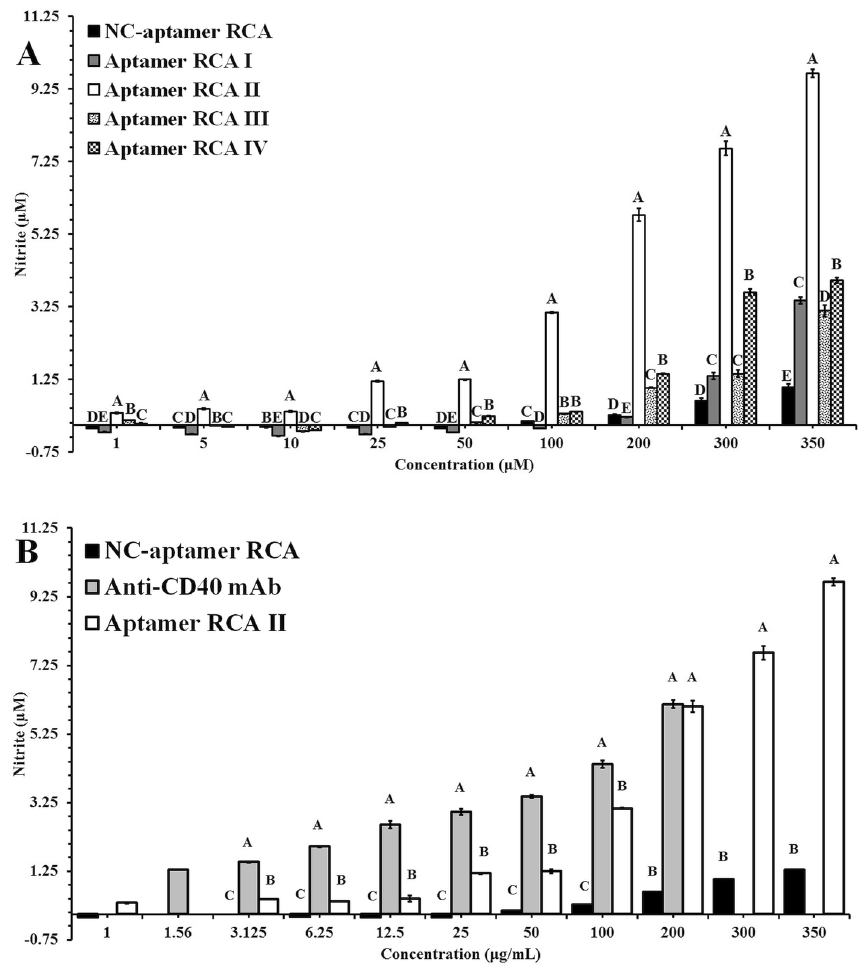
Figure 2. Nitric oxide liberation from chicken HD11 macrophage cell line over increased concentrations of RCA products (( A ) RCA I to RCA IV in comparison with NC-RCA, ( B ) RCA I in comparison with NC-RCA and anti-chicken CD40 MAb). The RCA products were incubated overnight with the HD11 macrophage cell line in concentrations 1, 5, 10, 25, 50, 100, 200, 300 and 350 (μg/mL) in triplicates. The nitric oxide liberated was measured using Griess assay and showed slop increasing in regard to dose applied. The result was compared to anti-chicken CD40 mAb which is known to have the effect on this cell line (Chen et al., 2010) and negative control RCA (two candidates randomly picked from the library and was not enriched in the Illumina sequencing results). Multiple way ANOVA and Tukey honest significant difference test (HSD) were applied to detect significant differences within treatments. Different uppercase letters represent difference at p <